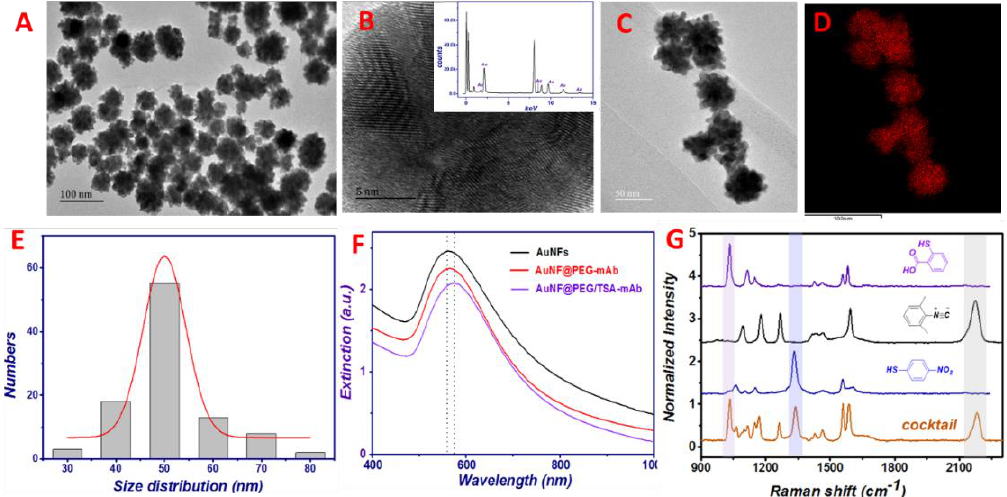
Figure 2. TEM images of the AuNFs ( A ) and the AuNF@PEG-mAb ( B ); the high-resolution AuNFs ( C ); zoomed-in TEM results of the AuNFs ( D ) and their corresponding EDS image; EDS result for the same area in Figure 2D (inner B ); ( E ) the size distribution of the synthesized AuNFs; ( F ) the extinction spectra of the different modified AuNFs; ( G ) SERS signals of different modified AuNFs and the label SERS